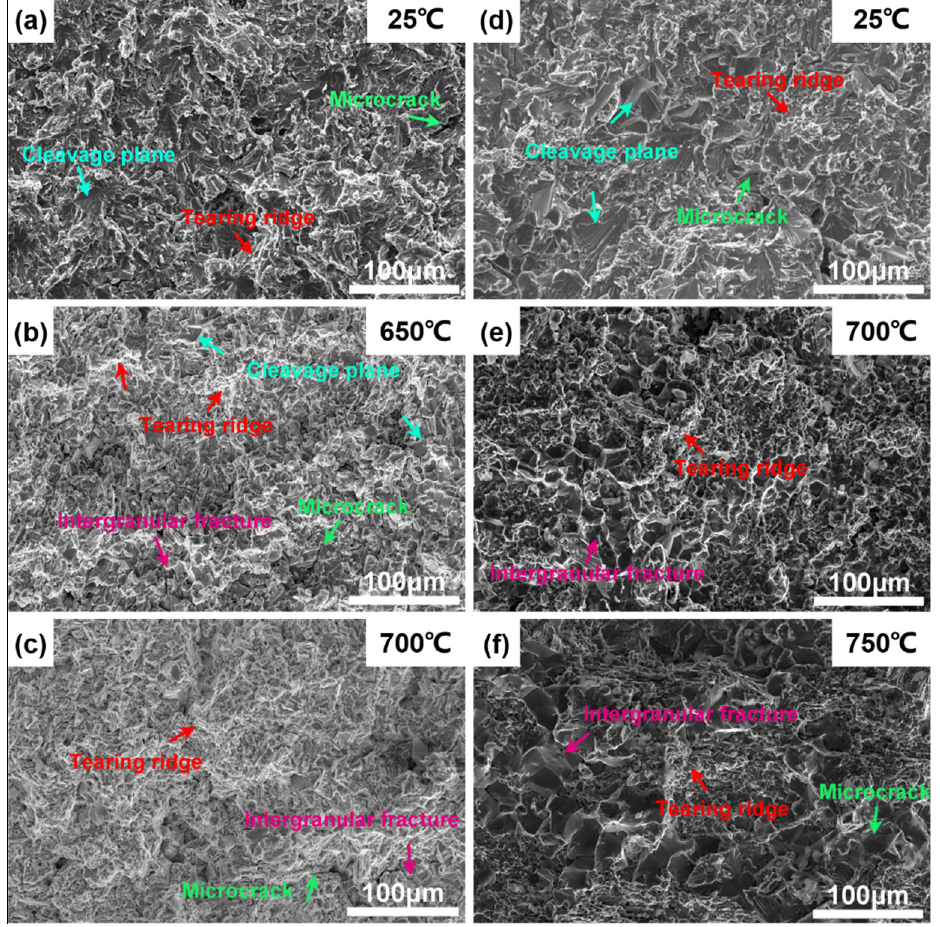
Figure 11. SEM micrographs of fracture surfaces on the tensile specimens of the HT4 state TiAlMn alloy and HT5 state TNM alloy: ( a – c ) The fracture surfaces of HT4 state TiAlMn alloy at different temperatures; ( d – f ) the fracture surfaces of HT5 state TNM alloy at different temperatures.